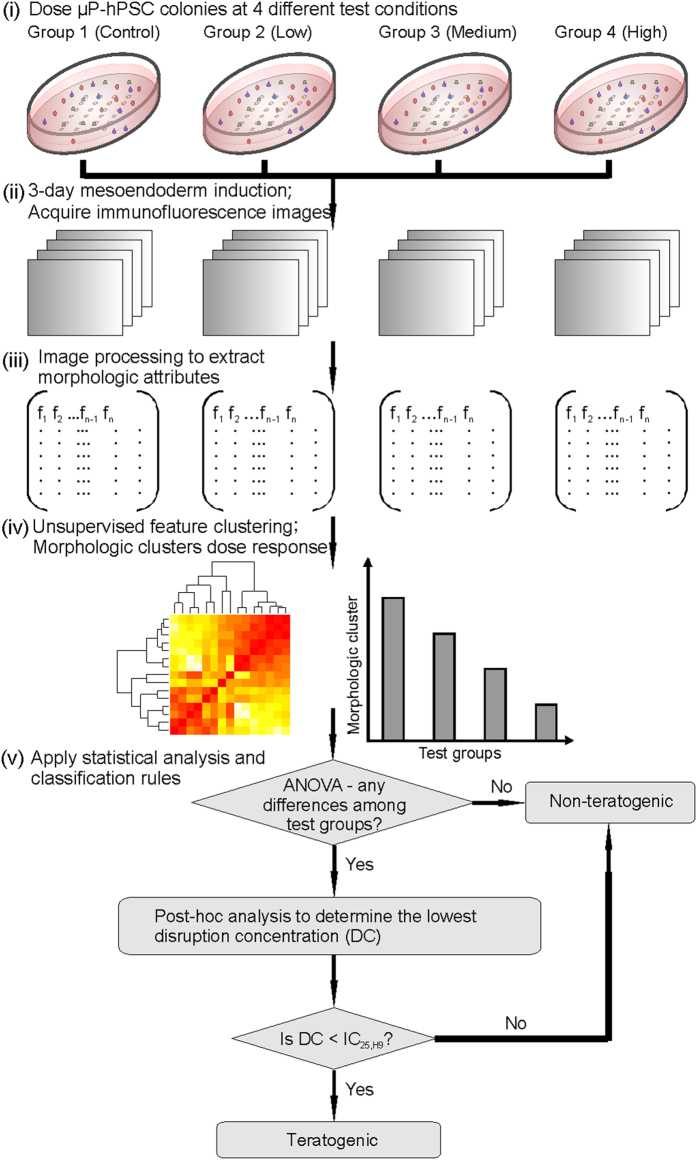
A quantitative morphometric assay for teratogen screening.Workflow for using the μP-hPSC model to determine the teratogenic potential of a test compound. Disruption concentration (DC) refers to the lowest concentration which morphologically disrupts the mesoendoderm pattern.